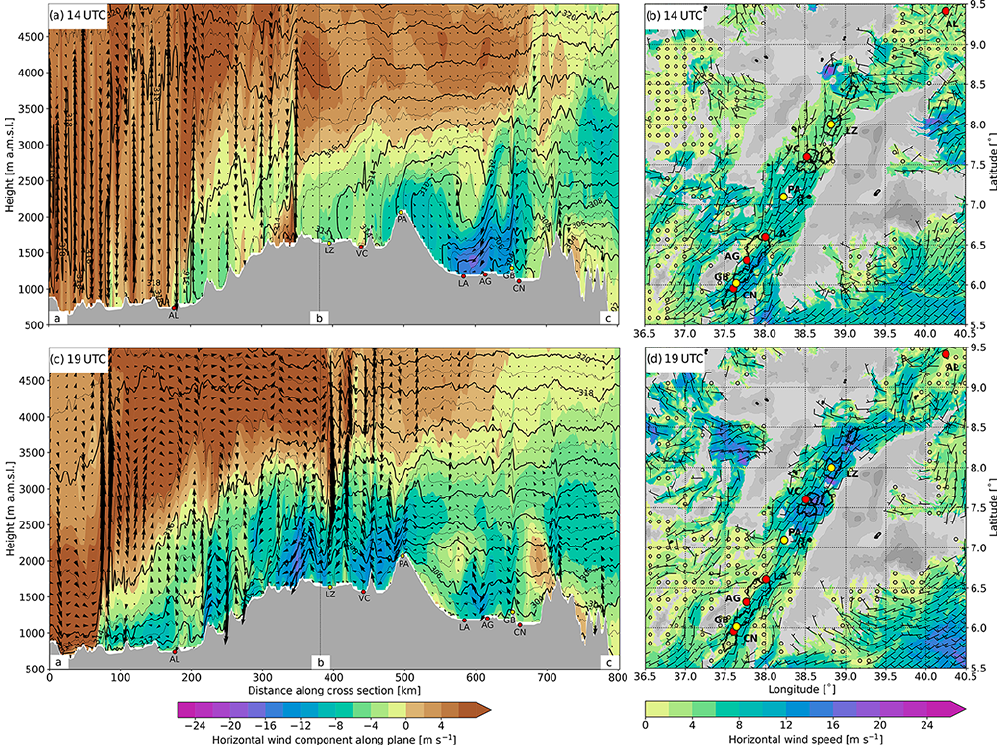
Figure 9. As in Fig. 5 but for the south-western gap flow at (a) – (b) 14:00UTC and (c) – (d) 19:00UTC 5 June 2018. Notice the reversed colour scale in (a) and (c) compared to Fig. 5a,